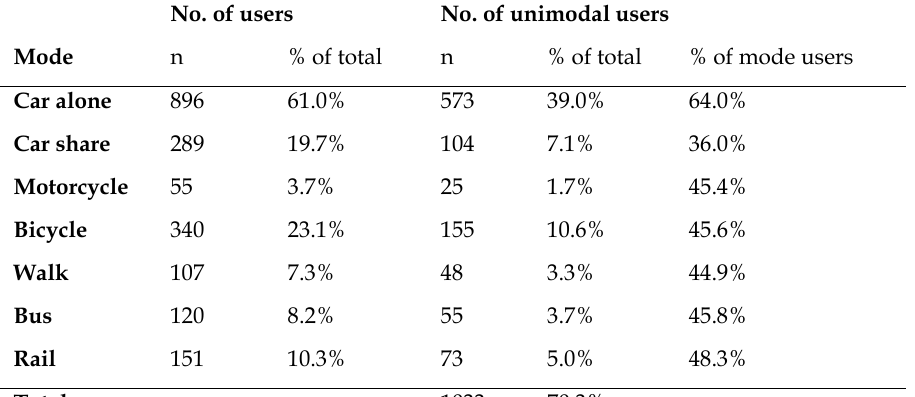
Table 6. Number of users of different modes and number of unimodal users at wave one